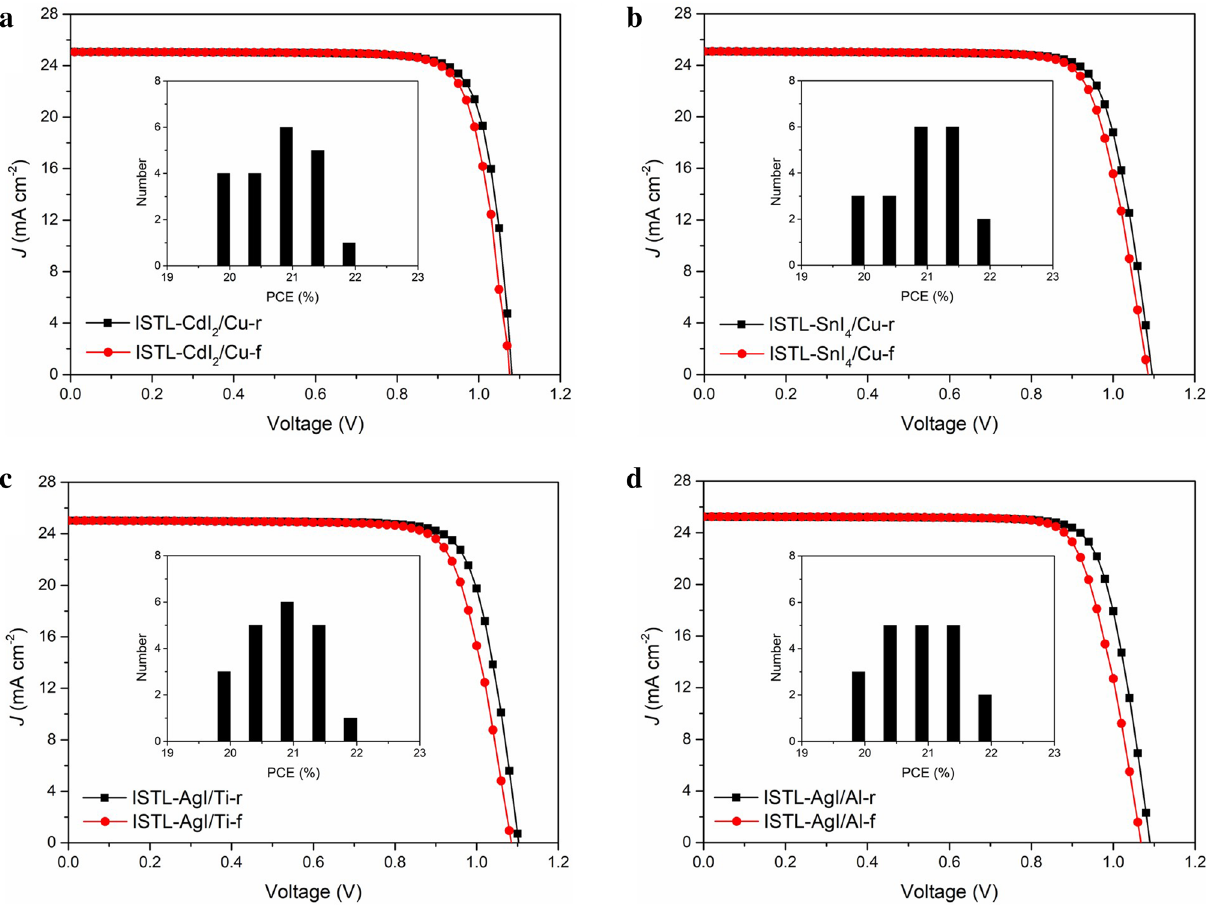
Fig. 5 J–V curves of champion PSCs with different ISTLs and low-WF anodes under reverse and forward scan. a ISTL-CdI 2 /Cu, b ISTL-SnI 4 / Cu, c ISTL-AgI/Ti and d ISTL-AgI/Al anode. Notes that the thickness of ISTLs and anodes is fixed at 5 nm and 80 nm, respectively. The insets in a–d are the histograms of average PCE value of twenty 0.09 cm 2 -devices with different ISTLs and